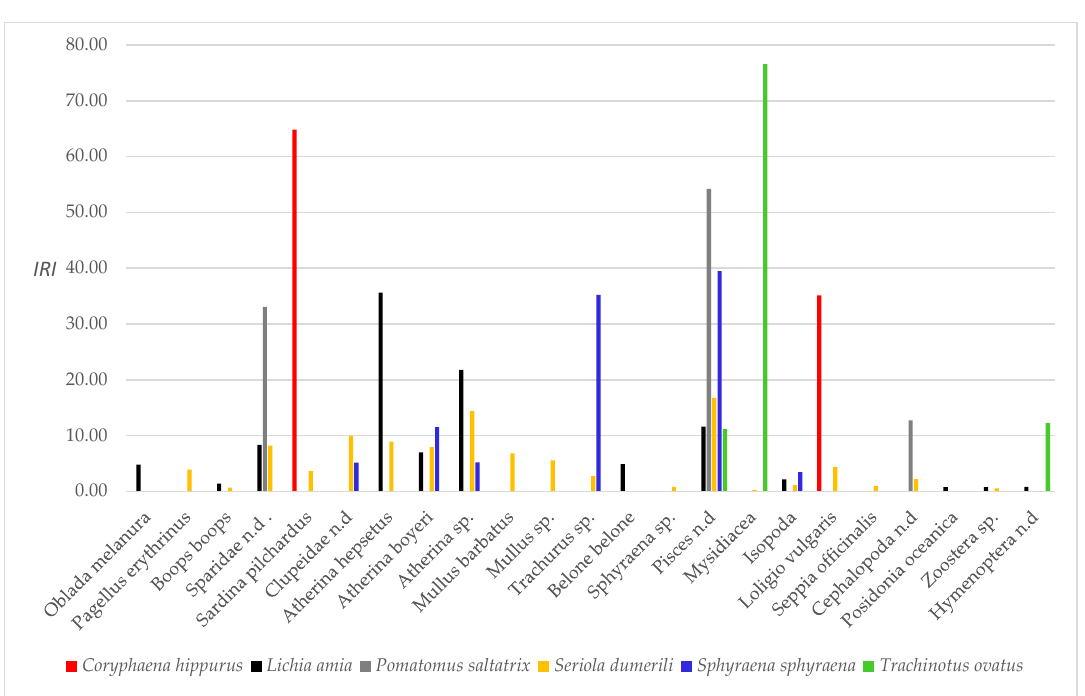
Figure 2. IRI prey importance for five fish species Coryphaena hippurus, Lichia amia, Pomatomus saltatrix, Seriola dumerili, Sphyraena sphyraena and Trachinotus ovatus caught in the Bay of Medulin. Important food items for L. amia, S dumerili and S. sphyraena were represented by species from the genus Atherina , but each of these three species seems to consume different Atherina species. Beside Atherina, significant food items for L. amia are represented by fishes from Sparidae family, for S. sphyraena from Carangidae family (including Trachurus sp.) and for S. dumerili fish from Clupeidae and Muliidae family (Table 1, Figure 2).